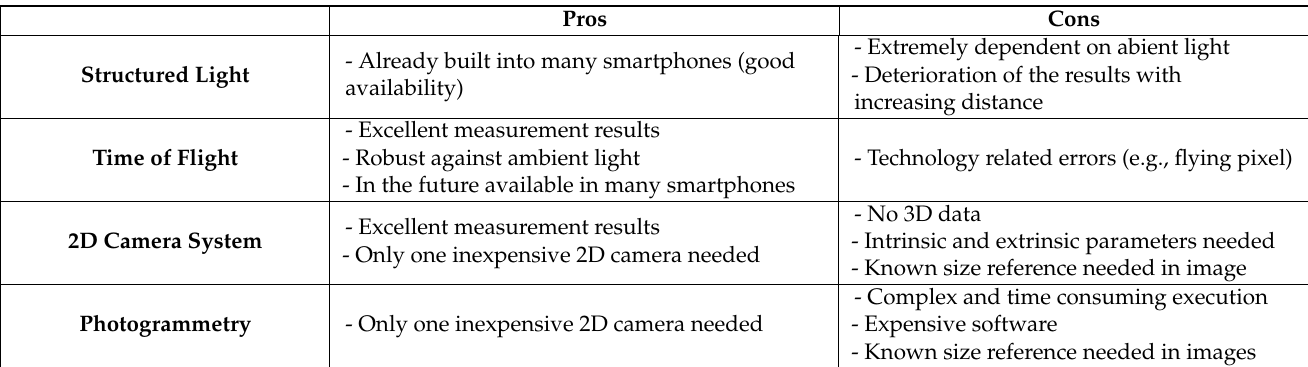
Table 4. Comparison of the advantages and disadvantages of the different